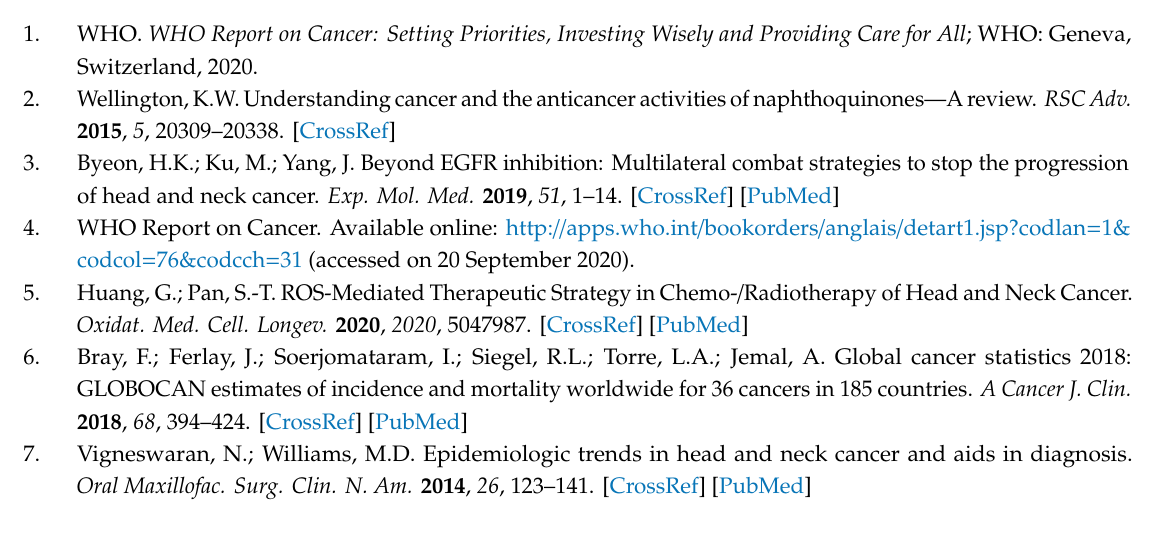
Figure S1: Original western blots for Figures 2–6, Table S1: Primary antibodies used for western